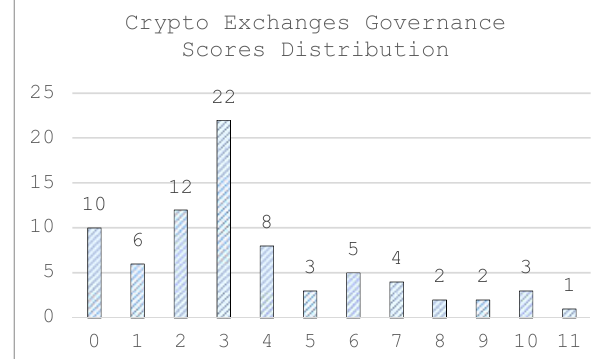
Chart 2: KPI Governance Scores Distribution